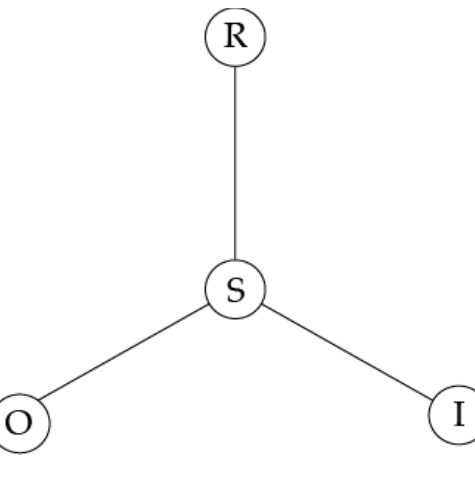
Figure 1. Peirce’s triadic sign